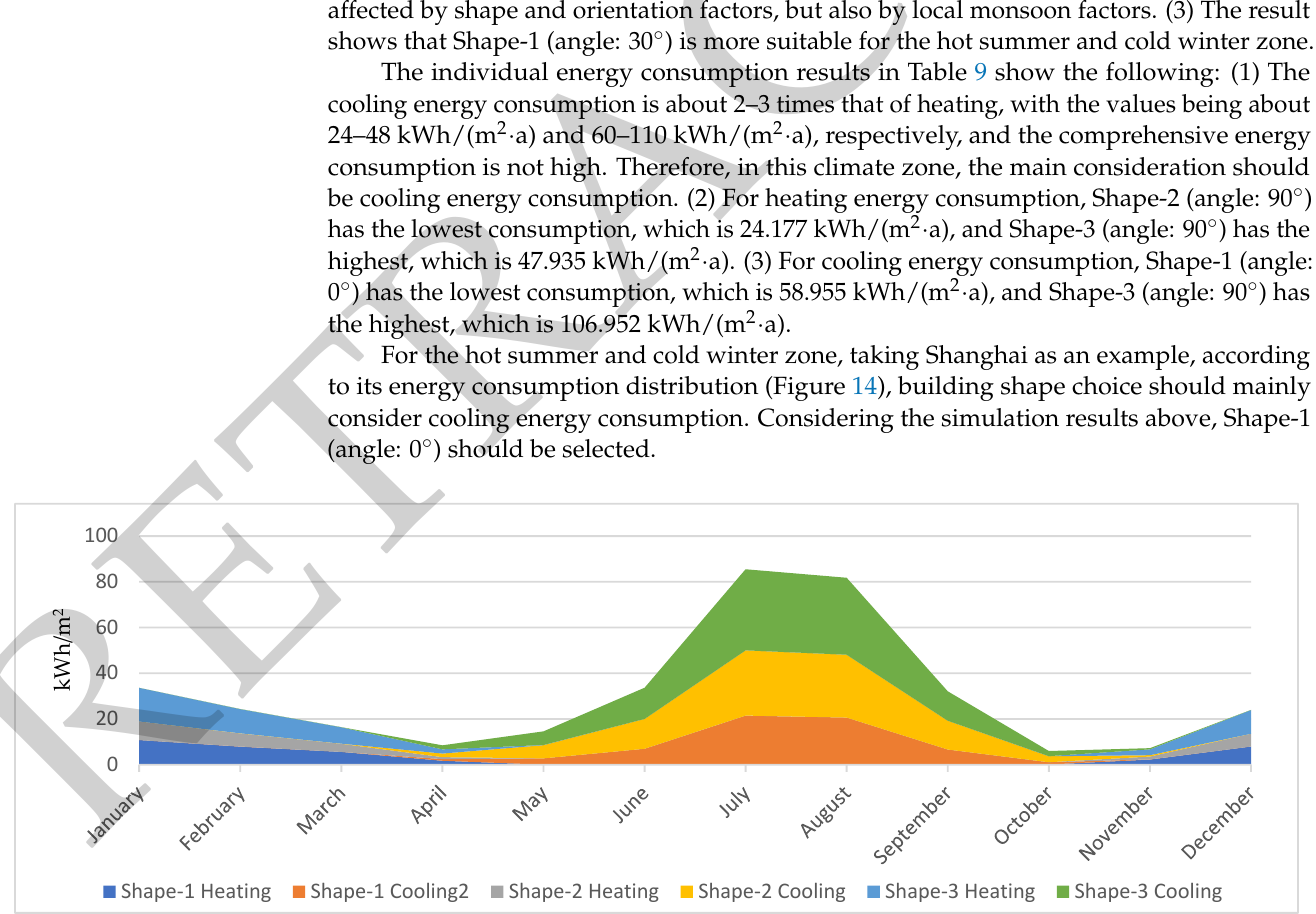
Figure 14. Monthly heating and cooling energy consumption in Shanghai.